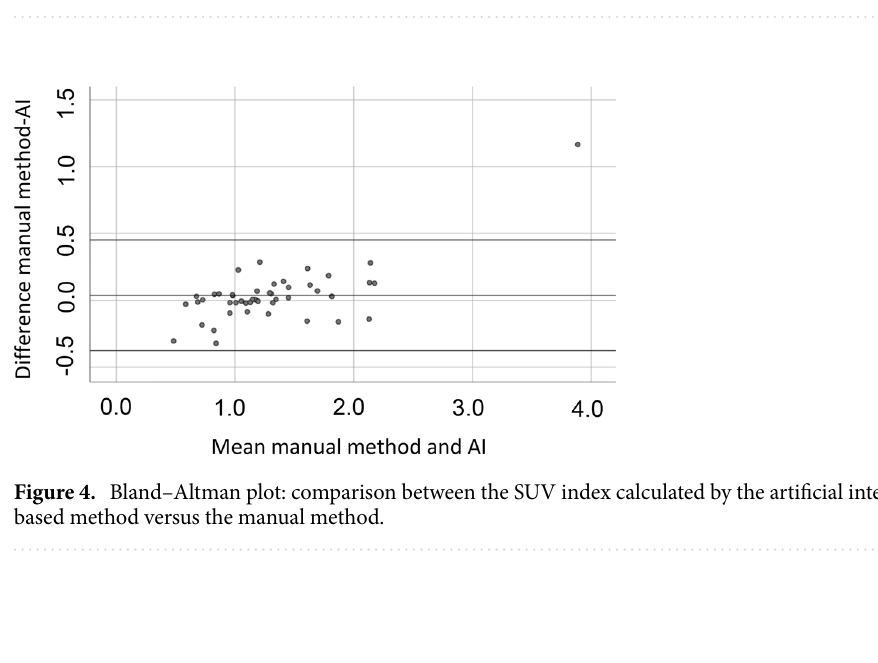
Figure 3. SUV index: (spine marrow uptake/liver) calculated by the artificial intelligence-based method compared with the physicians’ majority classifications of diffuse bone marrow uptake.